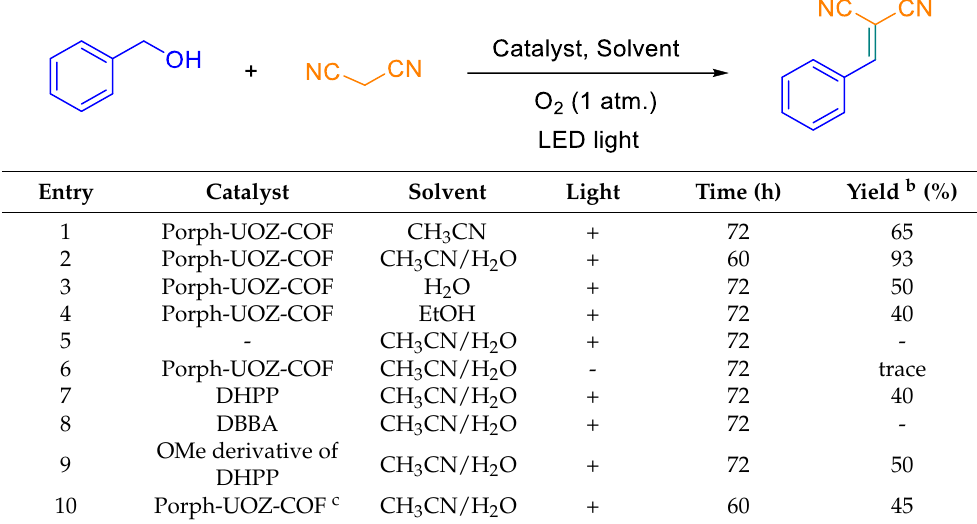
Table 2. Scope investigations for the one-pot tandem light- assisted synthesis of α,β -unsaturated nitriles using Porph-UOZ-COF as multifunctional catalyst a